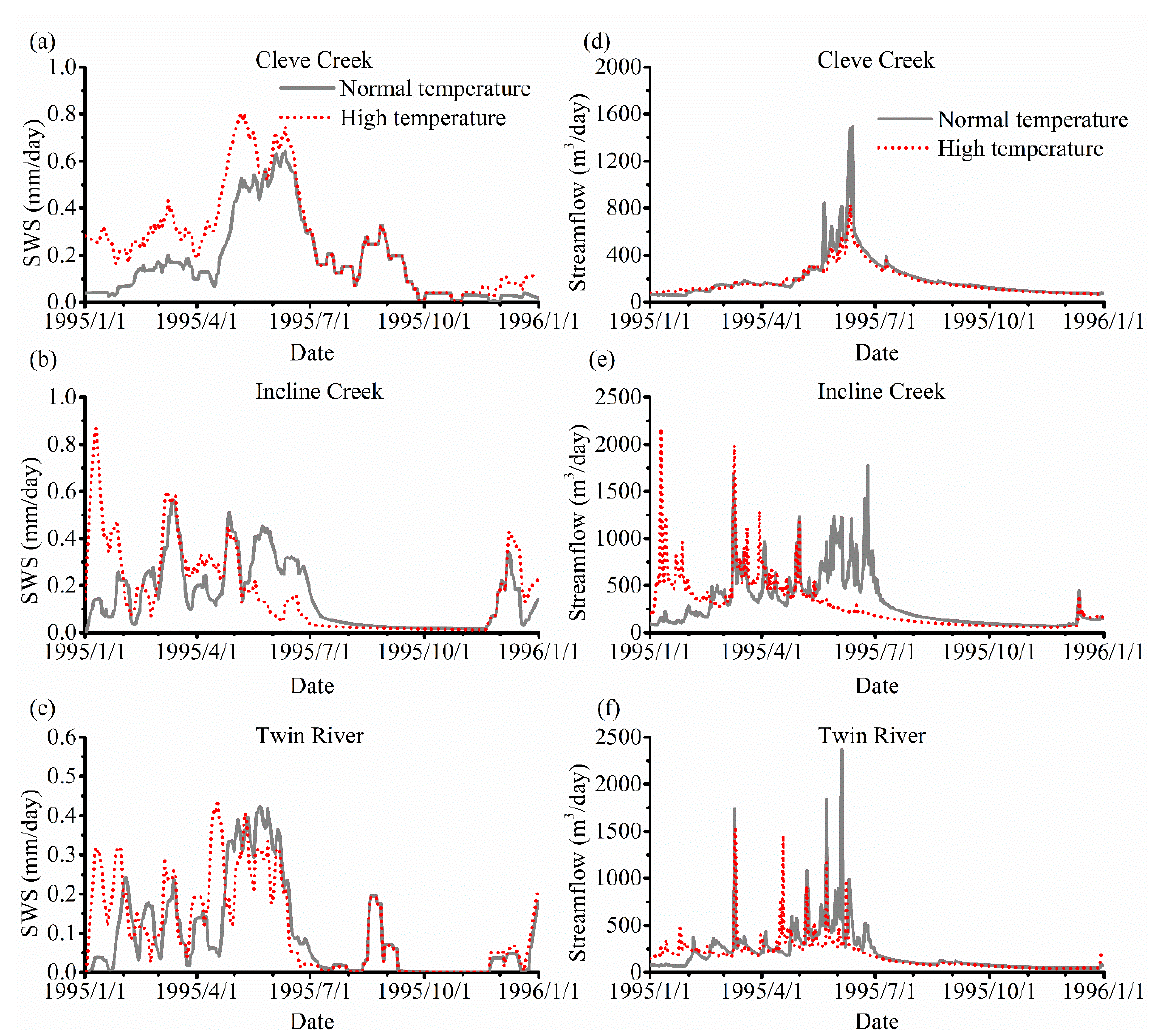
Figure 10. Comparison of soil water storage (SWS) and streamflow under the two different temperature scenarios without vegetation in 1995. The SWS of Cleve Creek, Incline Creek, and Twin River watersheds are shown in ( a – c ), respectively. The streamflow of Cleve Creek, Incline Creek, and Twin River watersheds are shown in ( d – f ), individually.